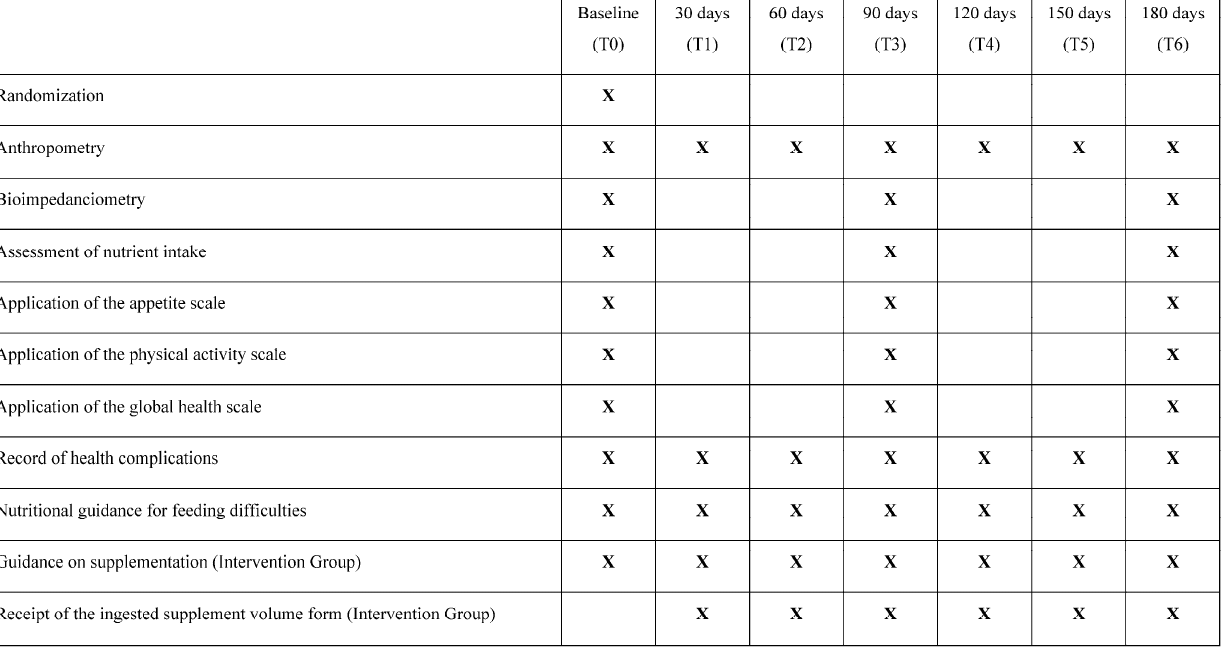
Figure 2. Details of the dynamics of the meetings during the 180 days of the study.